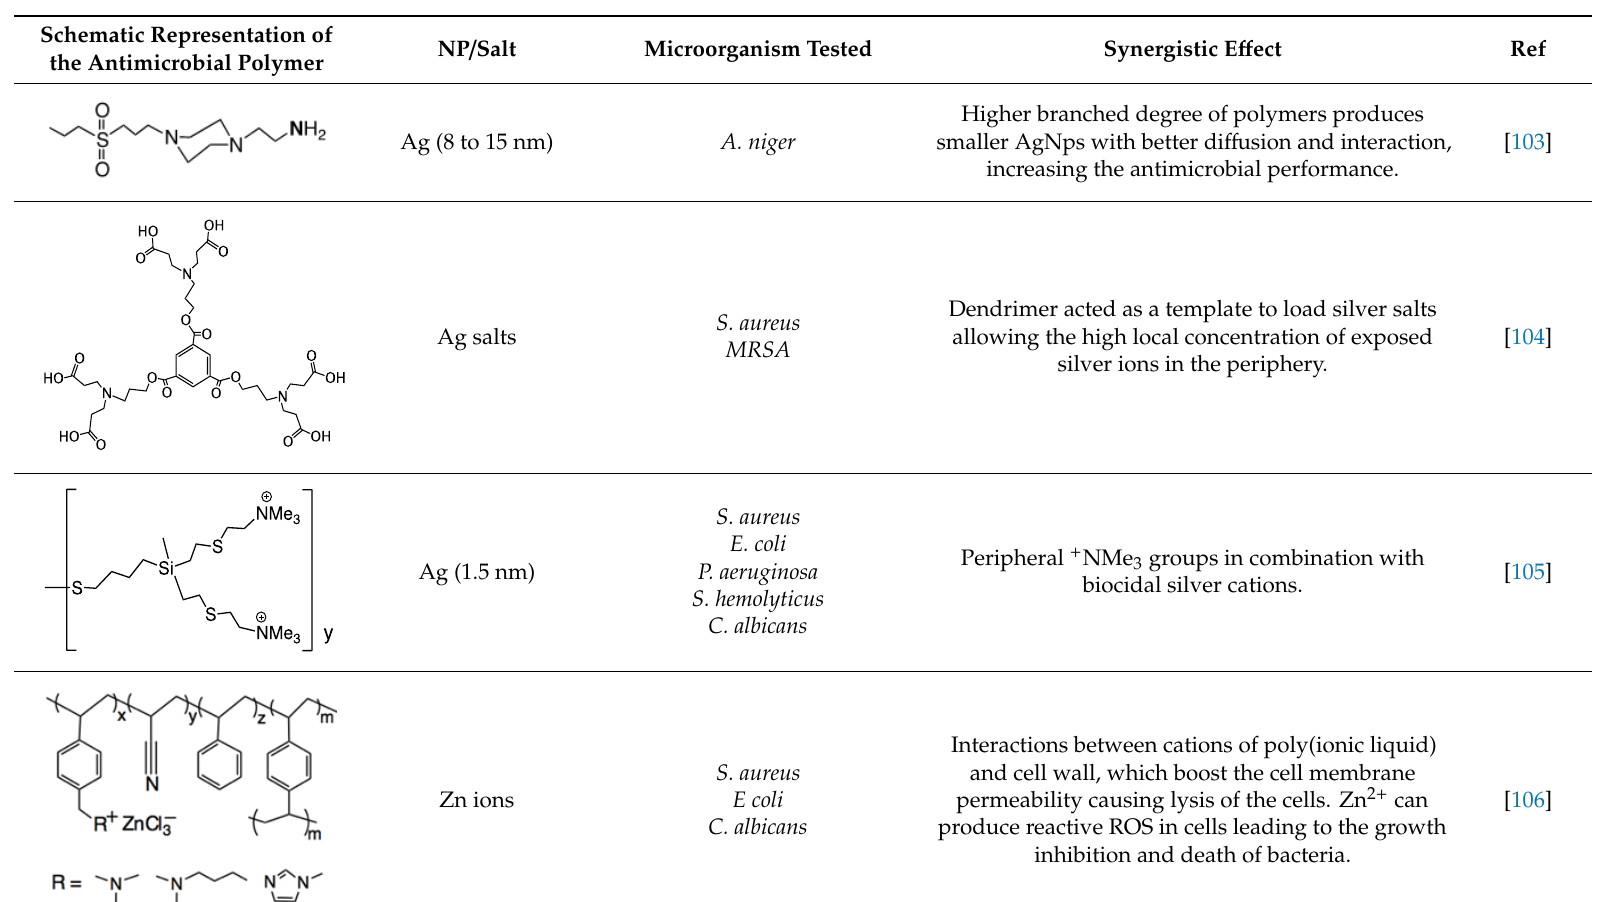
Interactions between cations of poly(ionic liquid) S. aureus and cell wall, which boost the cell membrane E coli Zn ions permeability causing lysis of the cells. Zn 2 + can produce reactive ROS in cells leading to the growth inhibition and death of